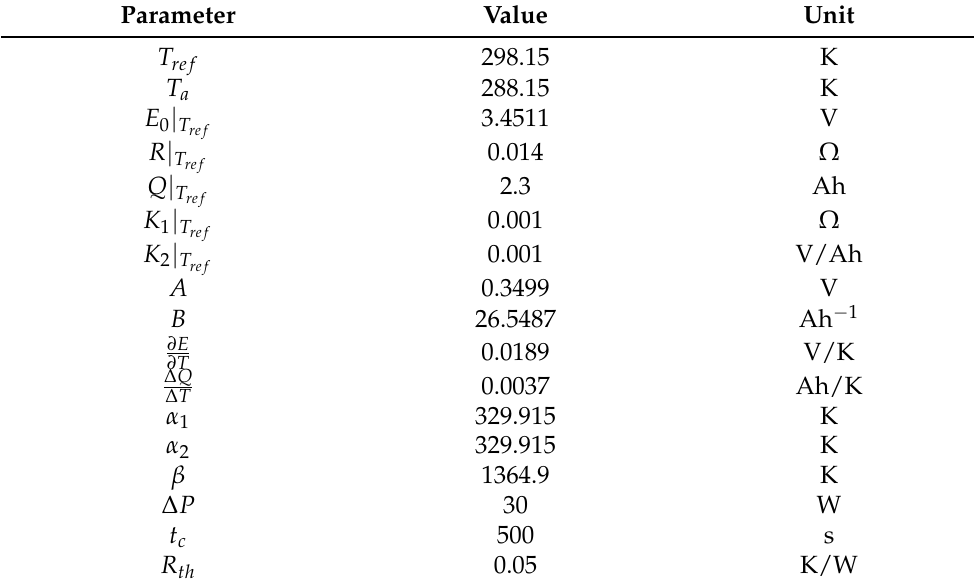
Table 4. Nominal parameters of the simulated Li-ion battery.